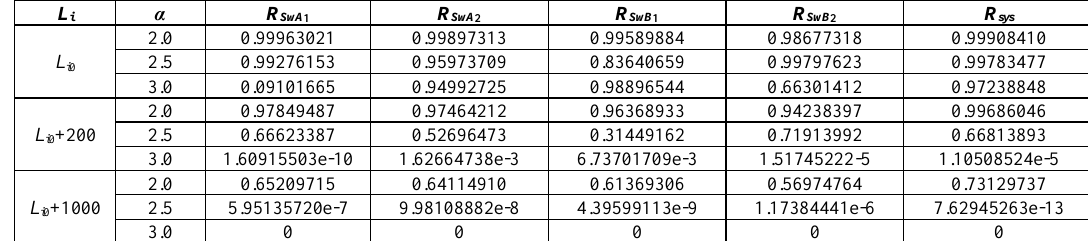
Table 11. Switch reliability ( R i ) and SAN reliability ( R sys ) under different loads L i and α i at t= 8640h